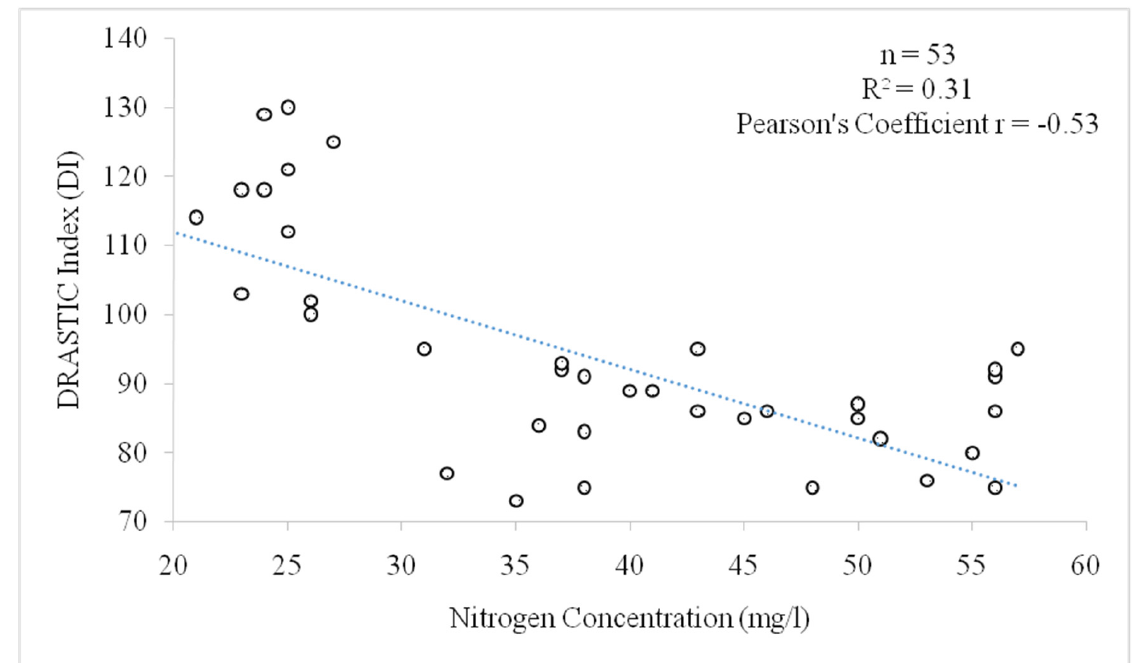
16 of 23 Figure 9. Map showing the concentration of nitrates in the groundwater of Chitral district. A correlation was developed between the values of nitrate concentration, DRASTIC index, and modified DRASTIC index. A relationship is used to examine the association between two computable and continuous variables. An appropriate correlation was made